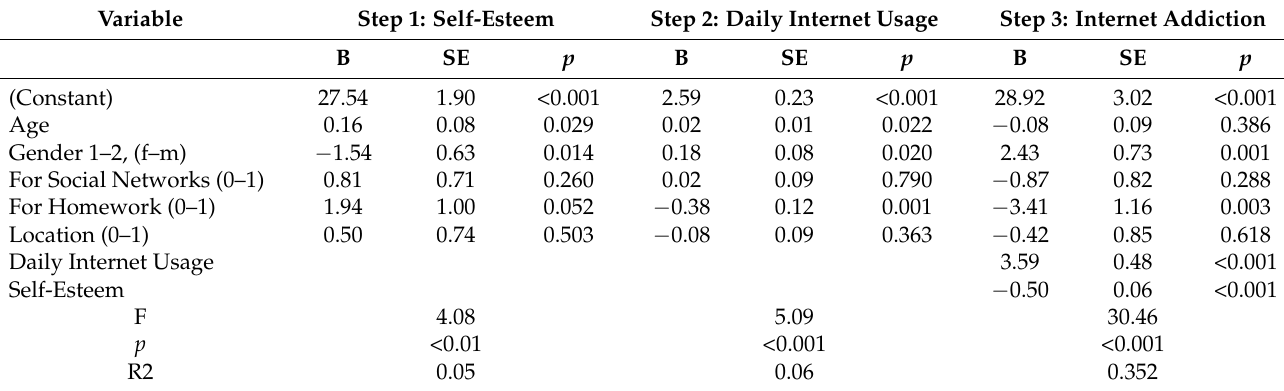
Table 3. Direct main effects on self-esteem, daily internet usage, and internet